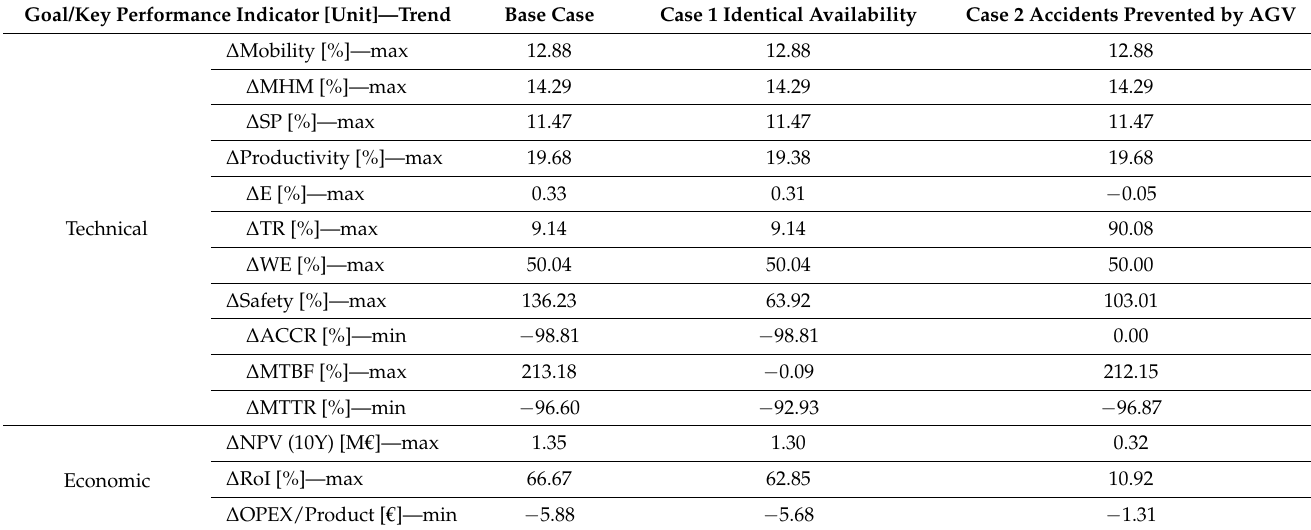
Table 4. Case analysis for the techno-economic 5G analysis for